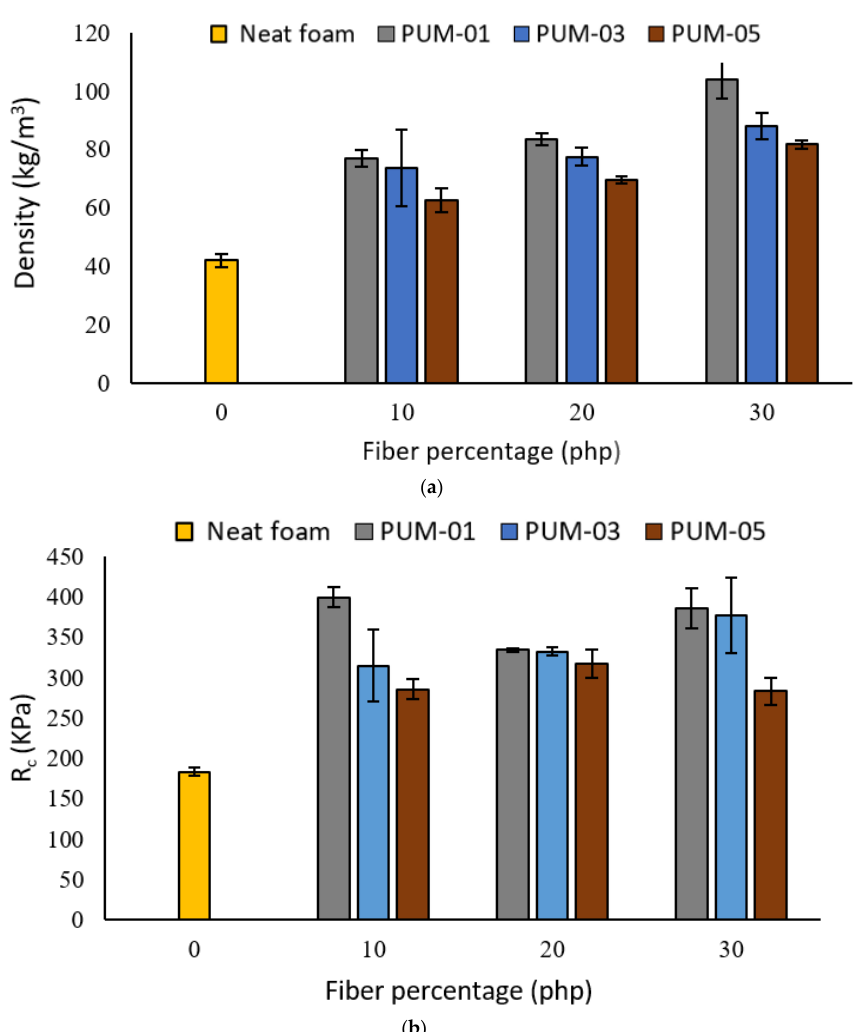
Figure 6. Effect of fiber particle size and percentage on reinforced foam properties: ( a ) density and ( b ) compressive strength.